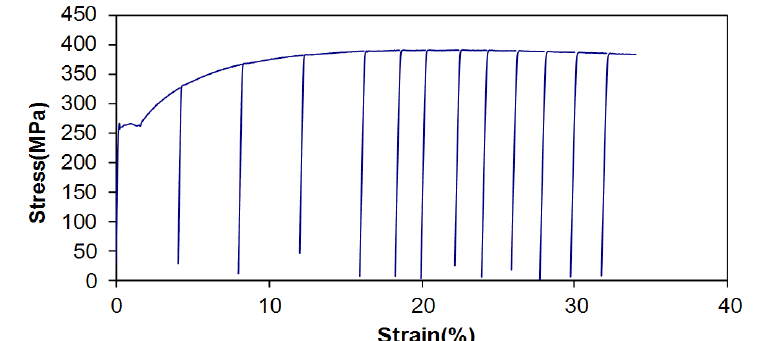
Figure 6: Stress-strain curve obtained during the loading and unloading operation for the flat tensile specimen.